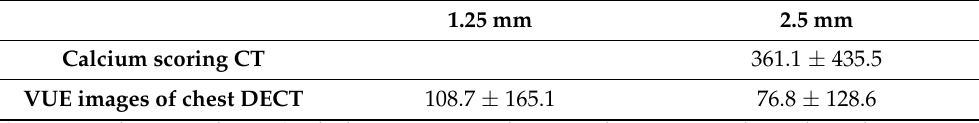
Table 3. Coronary artery calcium scores of calcium scoring CT and VUE images using chest